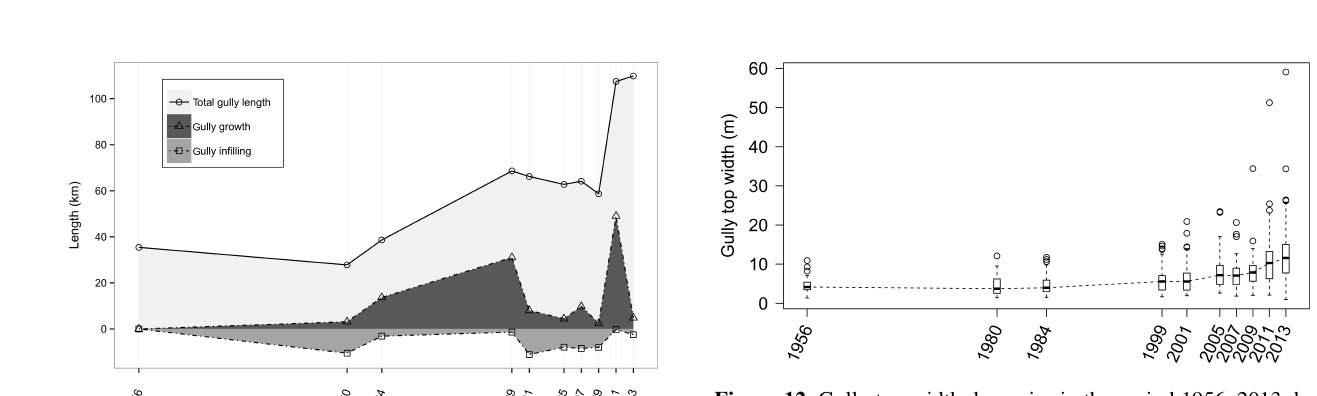
Figure 12. Gully top width dynamics in the period 1956–2013 de- rived by measuring by photointerpretation. The dashed line indi- cates the mean; box and whiskers indicate the 25–50 and 5–95% quantile ranges,